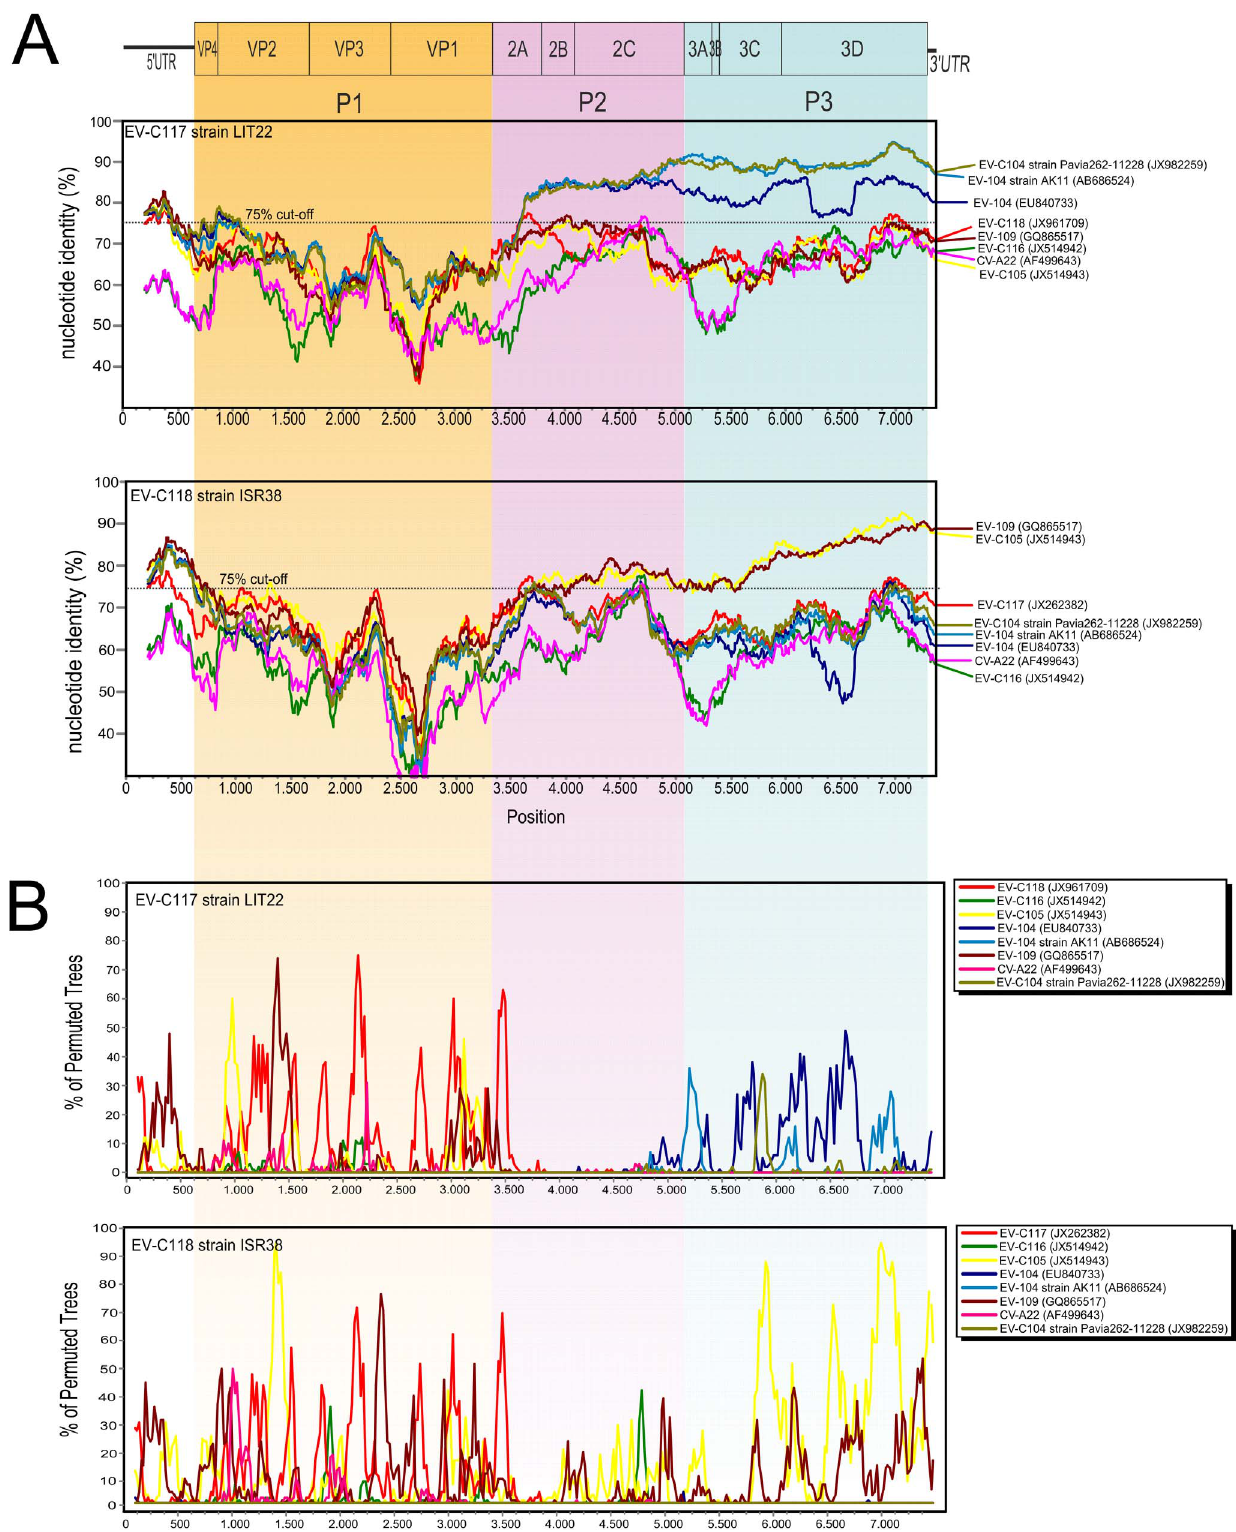
Figure 2. Similarity (A) and Bootscan plot of the complete EV-C117 and EV-C118 genome using a sliding window of 200 nt moving in 20 nt steps (B).